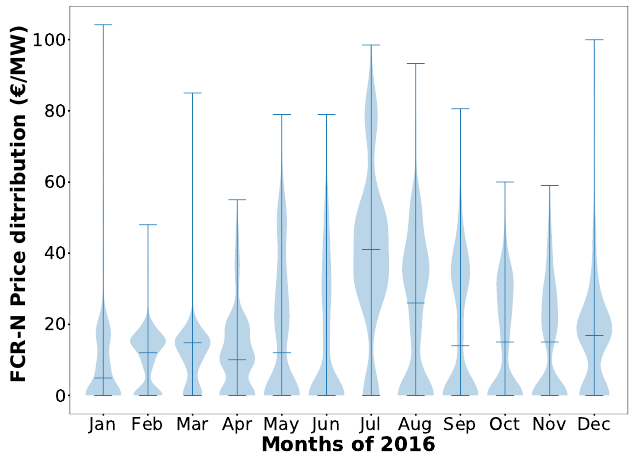
Figure 2. FCR-N price distribution by month for the year 2016, with representation of the median value.